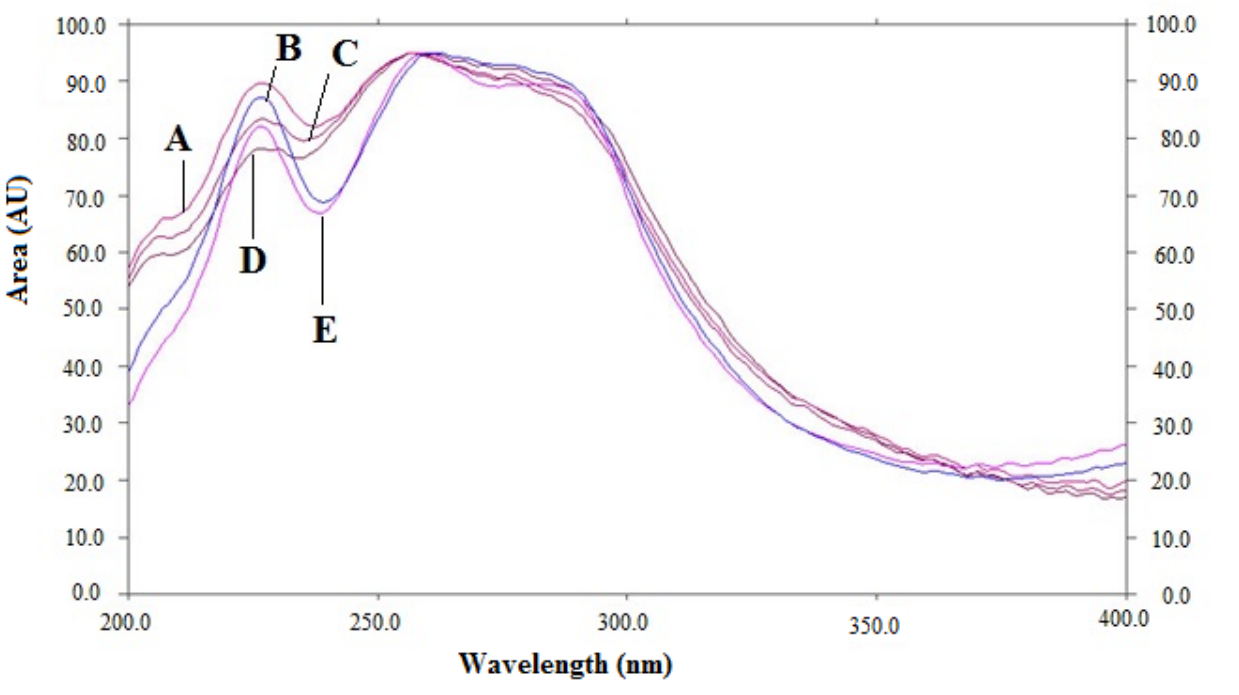
Figure 5. Superimposed ultraviolet (UV) spectra of (A) standard rhein and aloe-emodin, (B) ultra- sound-based extract (UBE) of commercial Rhubarb, (C) UBE of Rhubarb plant extract, (D) traditional extract (TE) of commercial Rhubarb, and (E) TE of Rhubarb plant